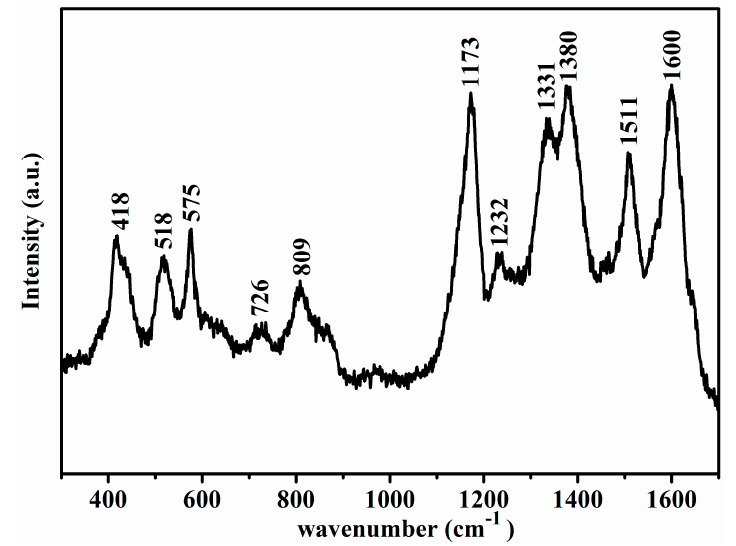
Figure 2. Raman spectrum of the product prepared at CA/Ani = 0.5, APS/Ani = 1 with Ani of 2 mmol and ice bath for 24 h.